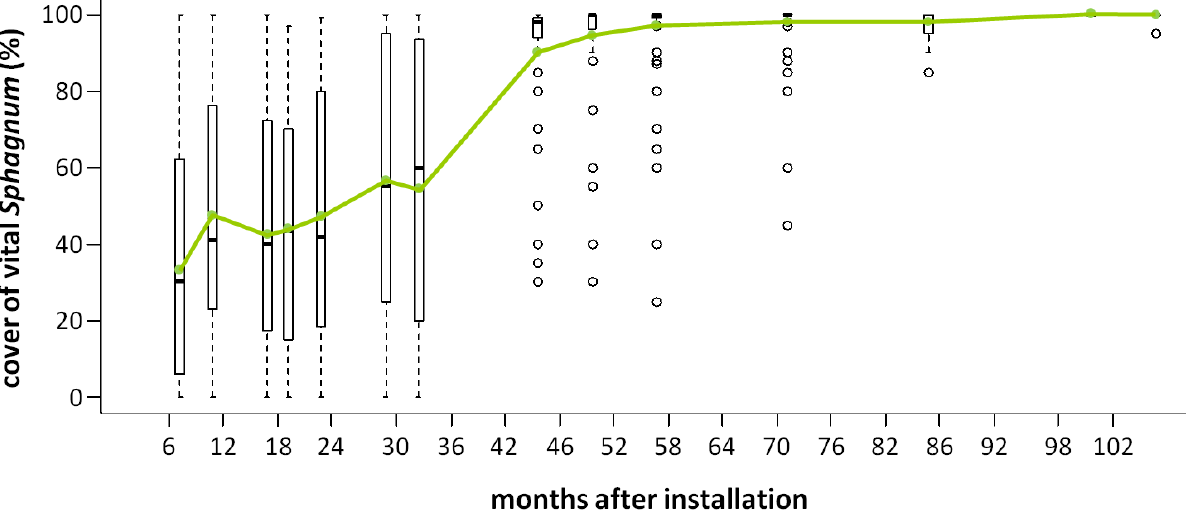
Figure 7. Cover of vital Sphagnum (%) at the study site for a period of 105 months after installation. For each observation date the plot shows the median (bold line), the upper and lower quartiles (the box includes 50 % of the data), the lowest value within 1.5 interquartile range (IQR) of the lower quartile (lower whisker), the highest value within 1.5 IQR of the upper quartile (upper whisker), and the outliers (i.e. values outside these ranges) (o). The green line connects the mean